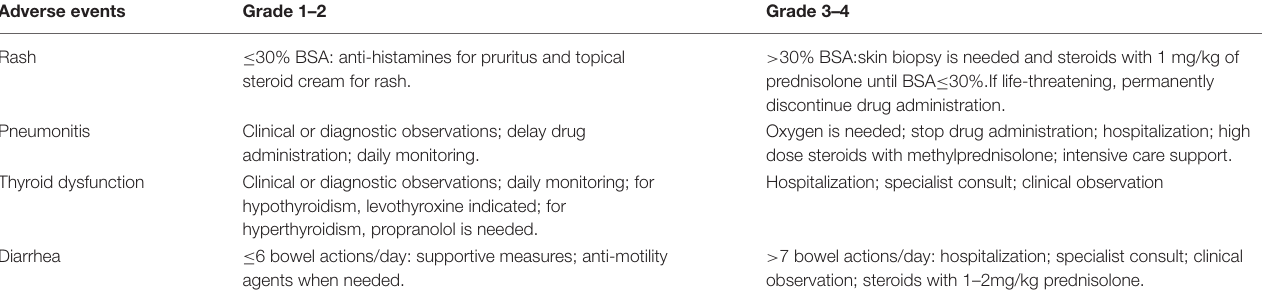
TABLE 5 | Management of treatment-related rash, pneumonitis, thyroid dysfunction and diarrhea (100). Adverse events